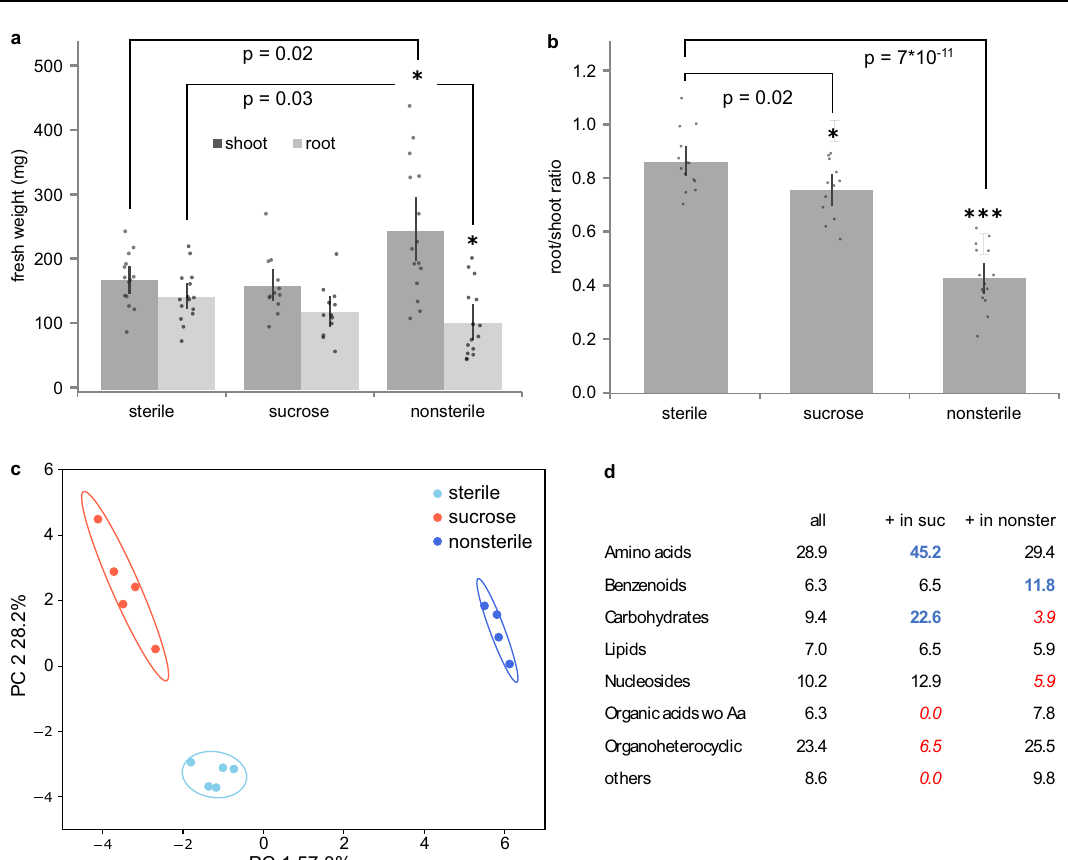
Fig. 2 | B. distachyon root exudation dynamics in different growth conditions. B. distachyon was grown for 3 weeks in sterile, nonsterile, and sucrose- supplemented conditions followed by exudate collection in the same 0.5 strength MS medium. Fresh weight of root and shoot a and root/shoot ratio b at 3 weeks. Data are averages±SEM, n =15 individual plants, *= p <0.05, ***= p <0.0005 (two- sided t-test). Root morphology of plants is described in Supplementary Fig. 4.